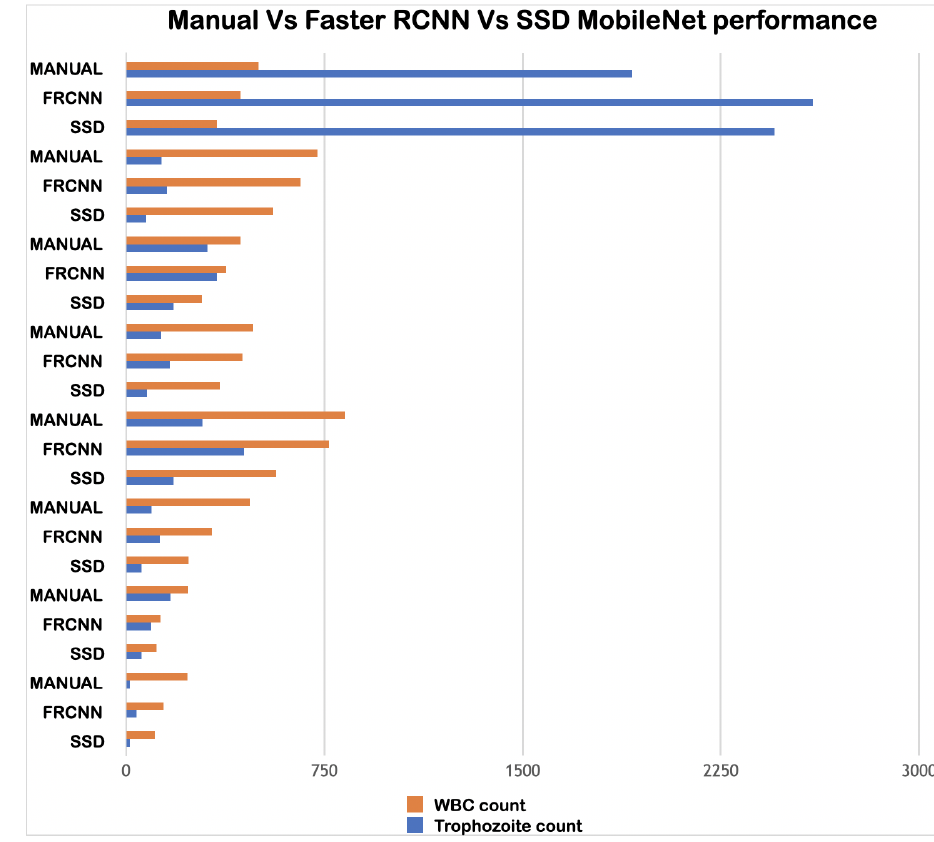
Figure 6. Manual experts vs Faster R-CNN model vs SSD model counts per blood film.